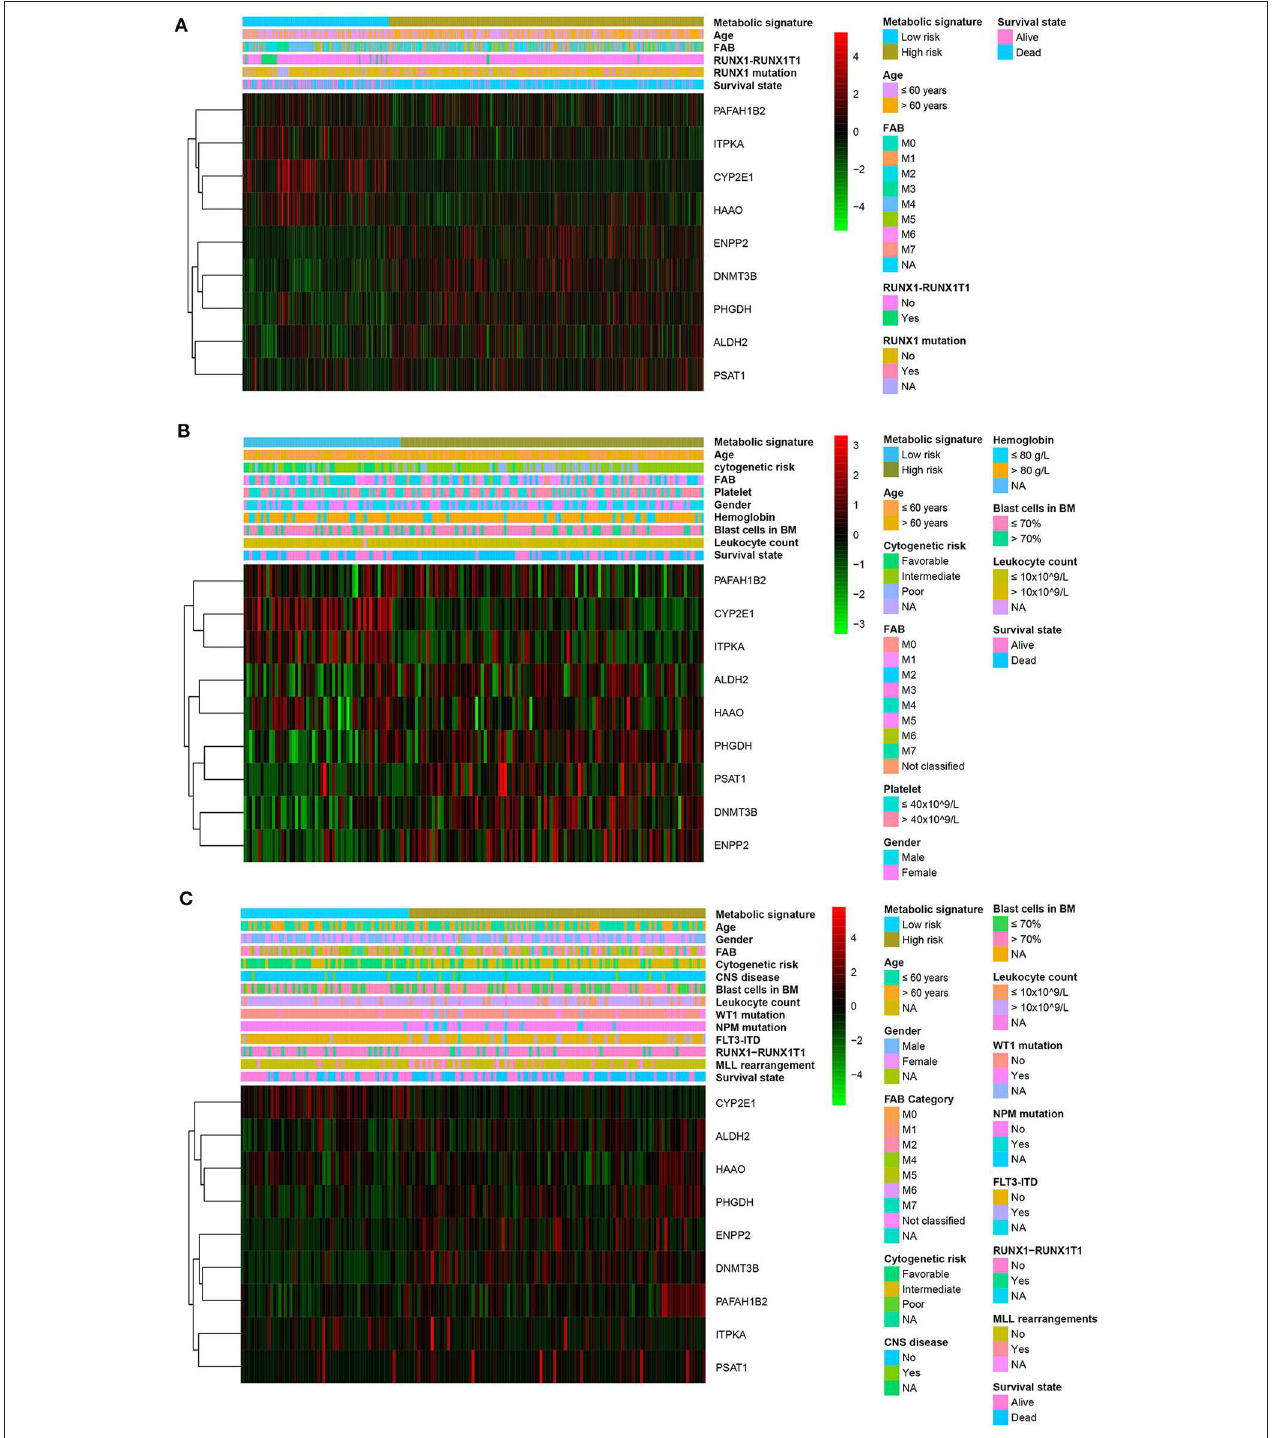
FIGURE 4 | Heatmap of the nine-gene signature and clinicopathological characteristics at different metabolic risk levels for training cohort (A) , adult external cohort (B) , and pediatric external cohort (C) . Each column showing gene expression or clinicopathological state represents a sample and each row represents one characteristic or gene in the model. The expression levels of the nine genes are shown in different colors. Blue and yellow indicate low- and high-risk levels, respectively. BM, bone marrow; FAB, French–American–British classification; NA, not available; CNS, central nervous system.